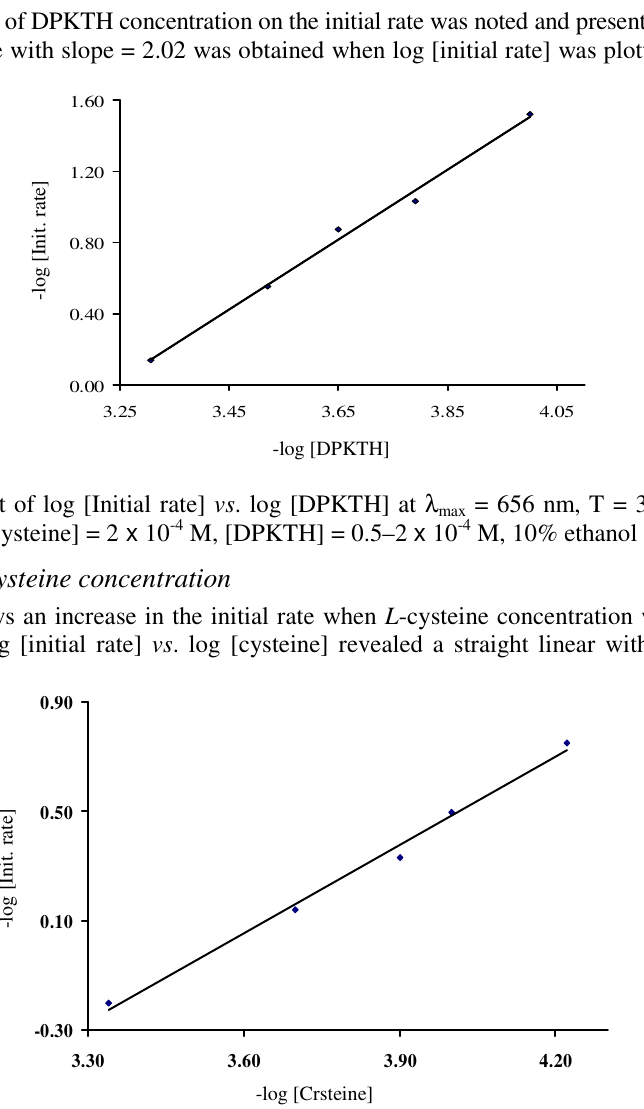
= 656 nm, T = 36 o C, [Fe 3+ ] = 1 x 10 -4 M, max